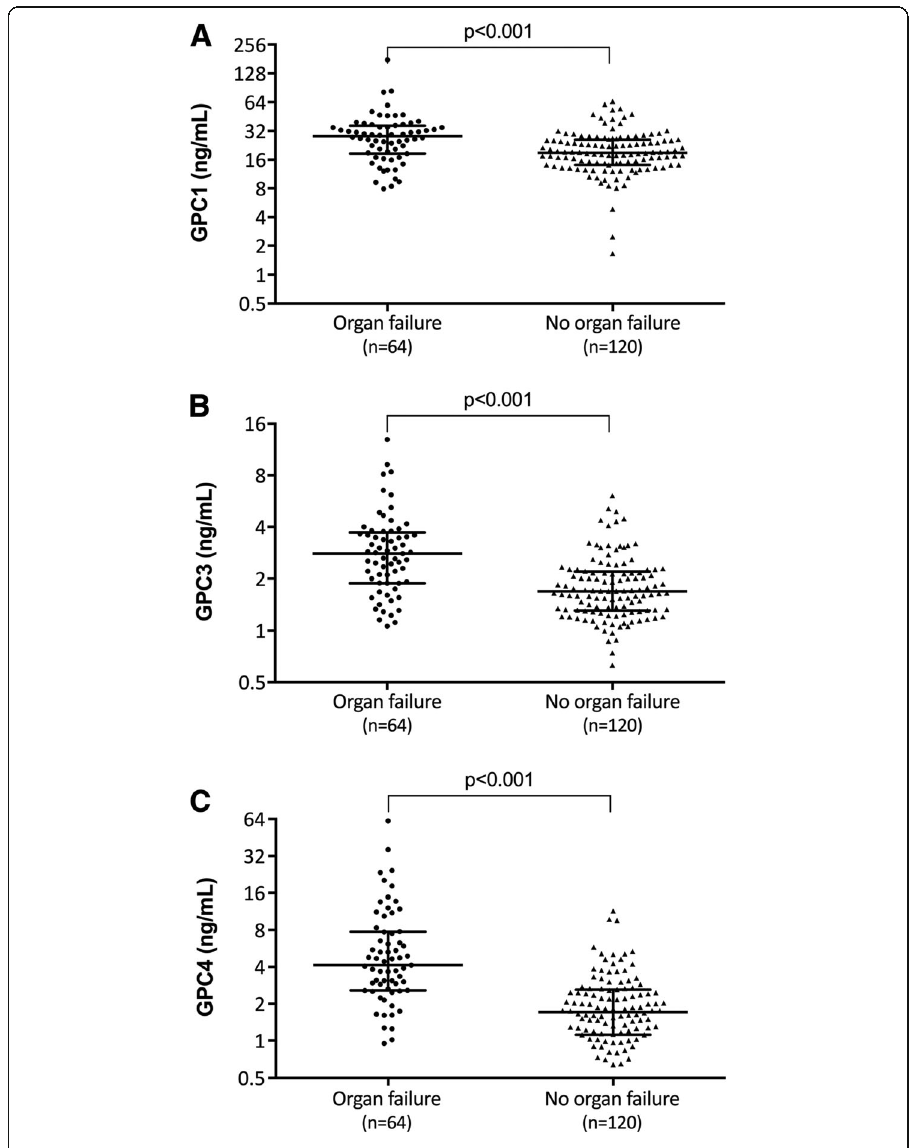
Fig. 2 Elevated plasma GPC1, 3, and 4 levels are associated with sepsis. a GPC 1, b GPC 3, and c GPC 4 levels were measured by ELISA in 184 patients with infection who were divided into groups based on the presence or absence of any organ failure. Differences between these groups were determined